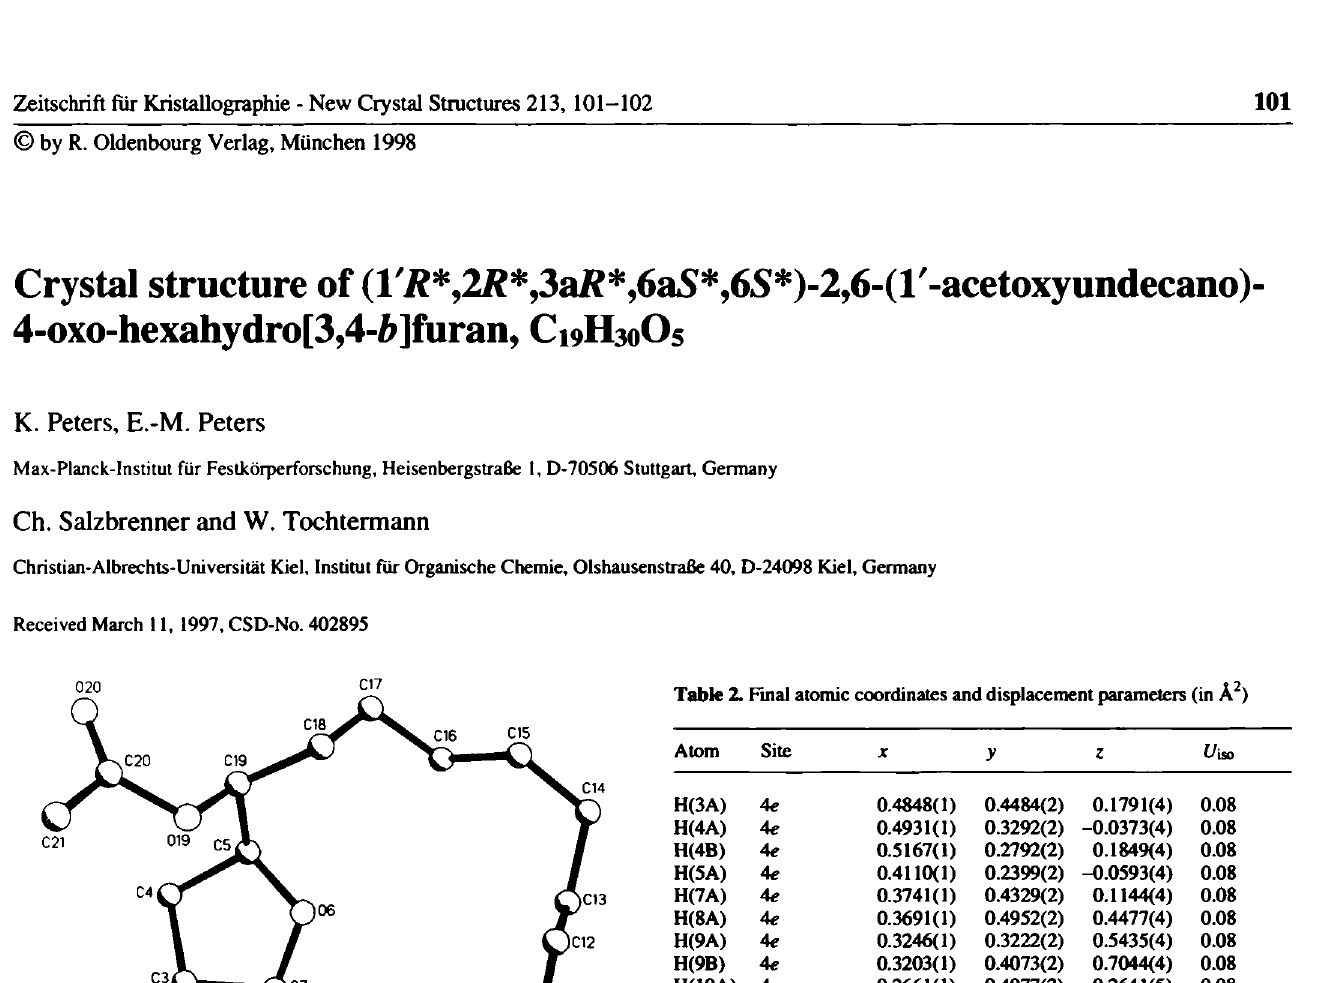
Table 2. Fmal atomic coordinates and displacement parameters (in Â^)